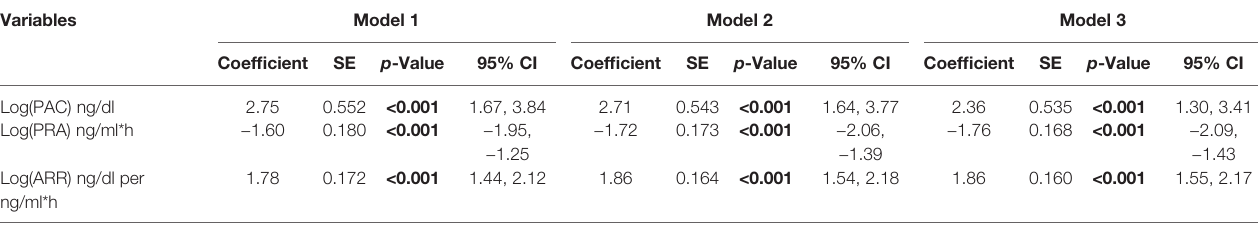
TABLE 3 | Correlation between PAC, PRA, ARR, and score of WMLs in linear regression analyses. Variables